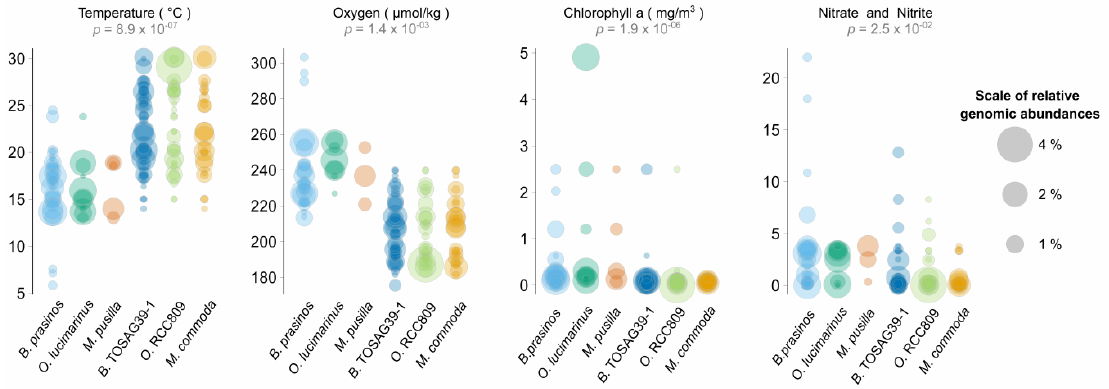
Figure 3. Ranges of values of environmental parameters where a significant di ff erence was detected among Mamiellales species. Each circle corresponds to the relative metagenomic abundance of corresponding species in a given sample. A sample where several species are present is thus represented for these corresponding species (at the same value on the Y axis) but possibly with di ff erent circle sizes. p -values correspond to a Kruskal–Wallis test using the six Mamiellales (non-significant environmental parameters are not shown).